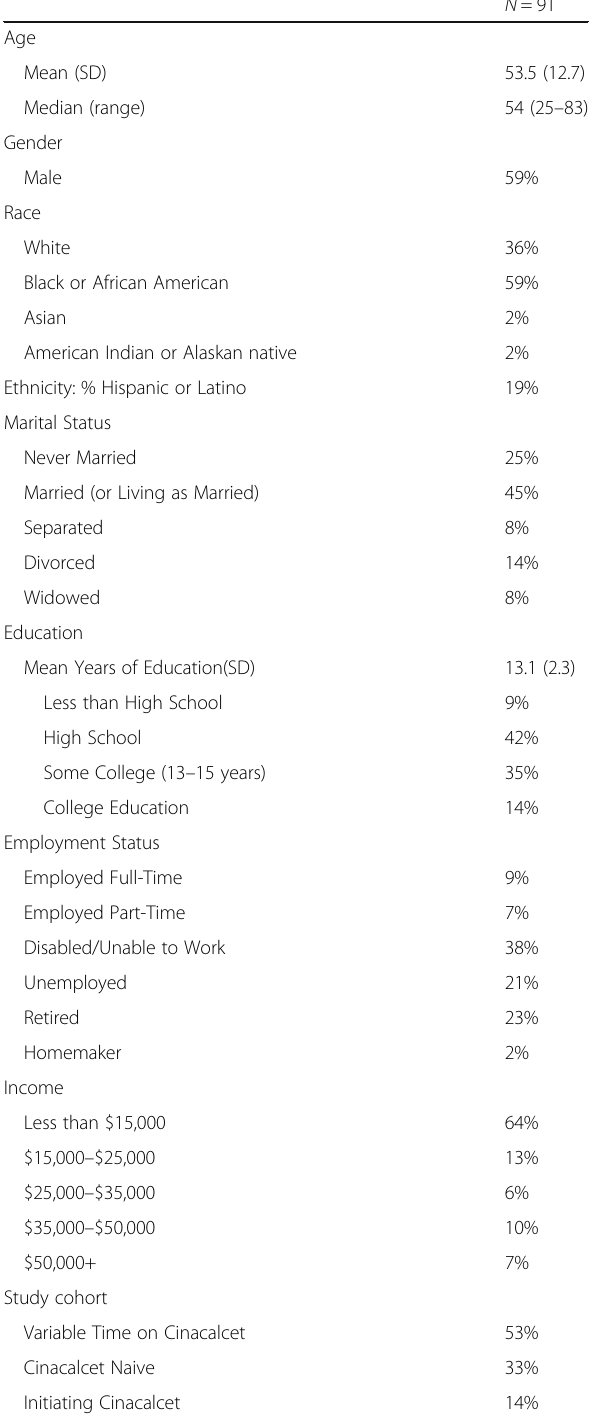
Table 1 Demographic and clinical characteristics of